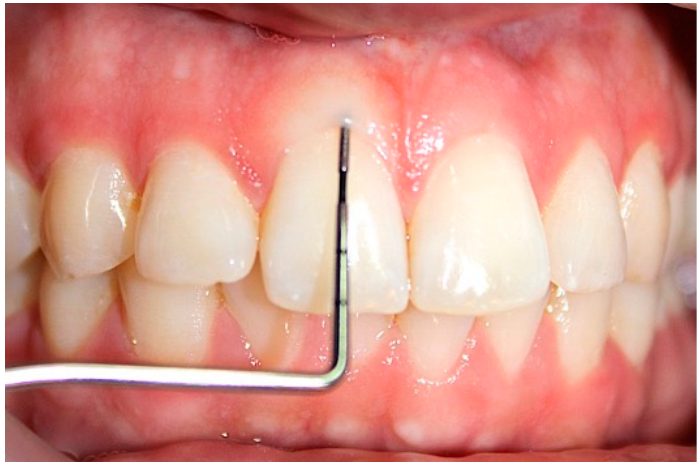
Figure 1. Transgingival probing by examining the gingival